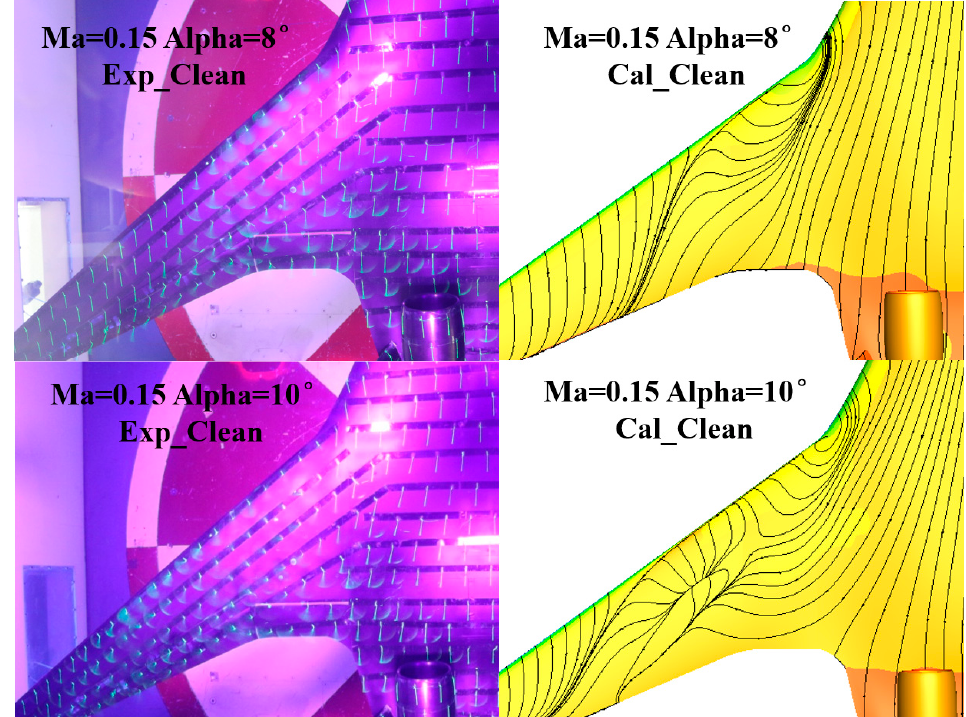
Figure 6. Aerodynamic coefficient results of computation and experiment for the clean configura- tion and the high lift configuration.